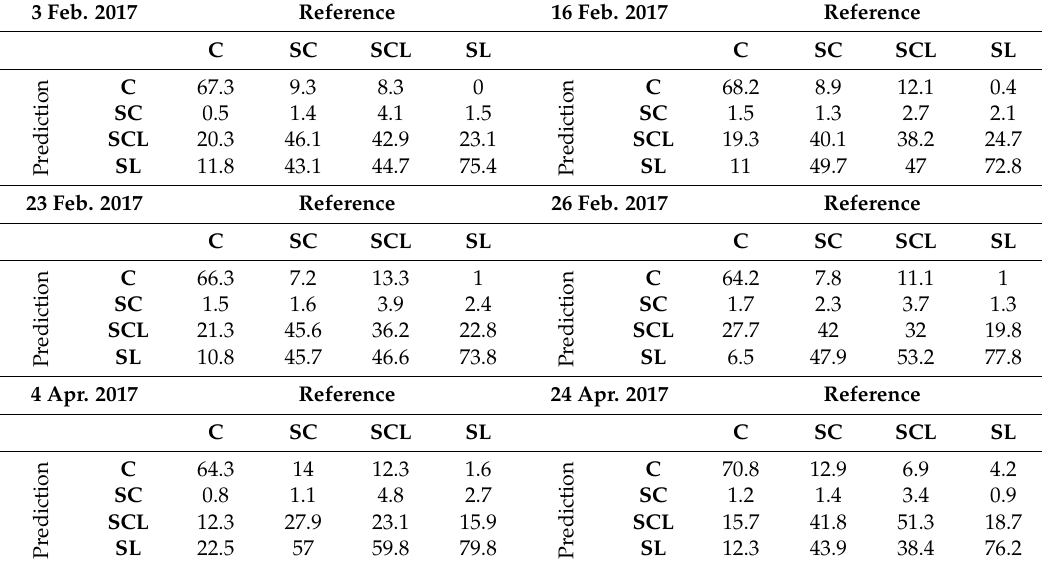
Figure 4. ( a ) Accuracy and ( b ) kappa coefficient obtained for 100 classification models built using each Sentinel-2 image. Table 1. Mean of Confusion Matrixes (expressed in %) obtained by the 100 classification models from each image. Each row of the confusion matrix represents the instances in a predicted class while each column represents the instances in an observed